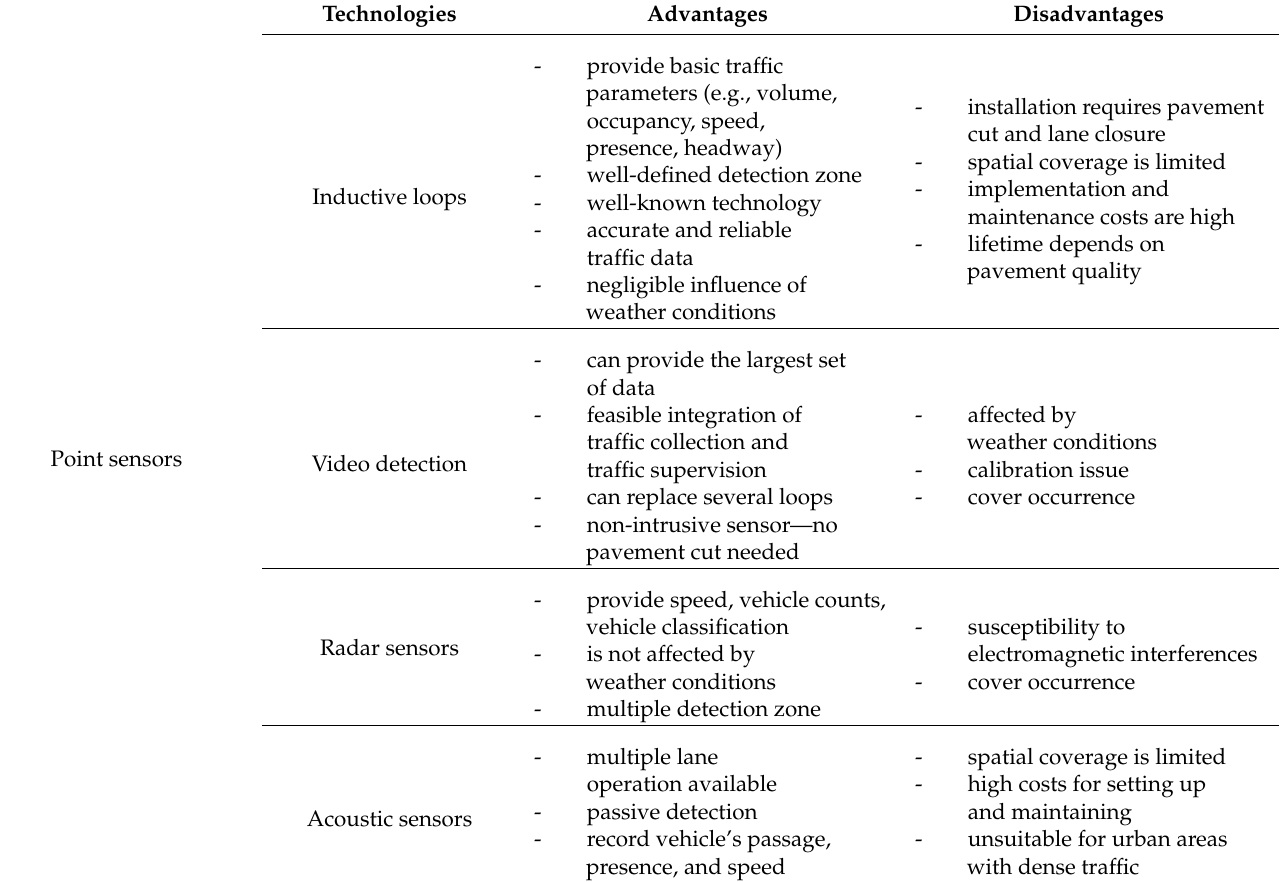
Table 3. Advantages and Disadvantages of Data Collection Technologies.